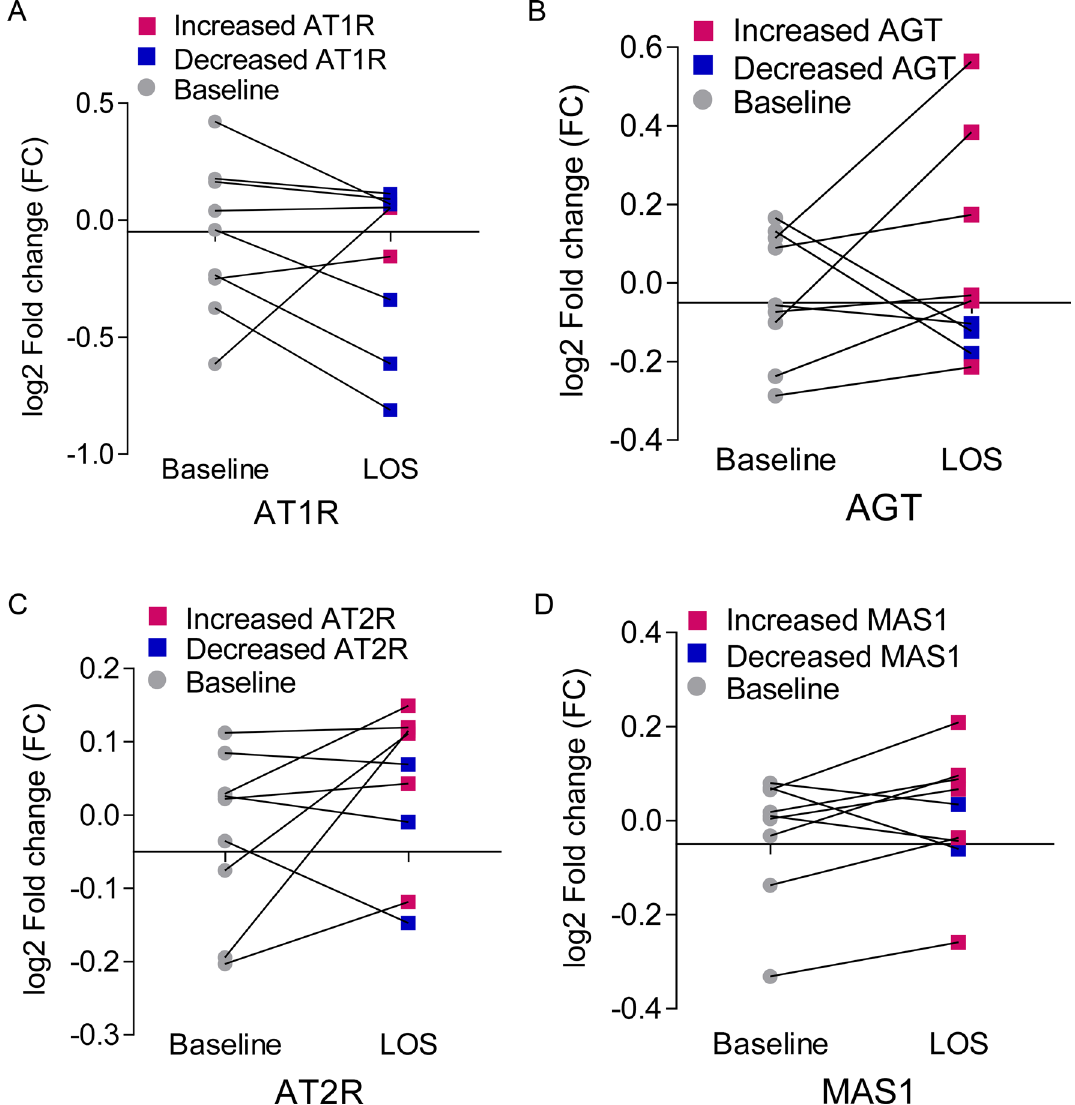
Figure 2. Response of RAS components to LOS among patients. ( A ) Increase and decrease response of AT1R of individual patients at baseline and at 6 weeks of LOS treatment. ( B ) Increase and decrease response of AGT of individual patients at baseline and at 6 weeks of LOS treatment. ( C ) Increase and decrease response of AT2R of individual patients at baseline and at 6 weeks of LOS treatment. ( D ) Increase and decrease response of MAS1 of individual patients at baseline and at 6 weeks of LOS